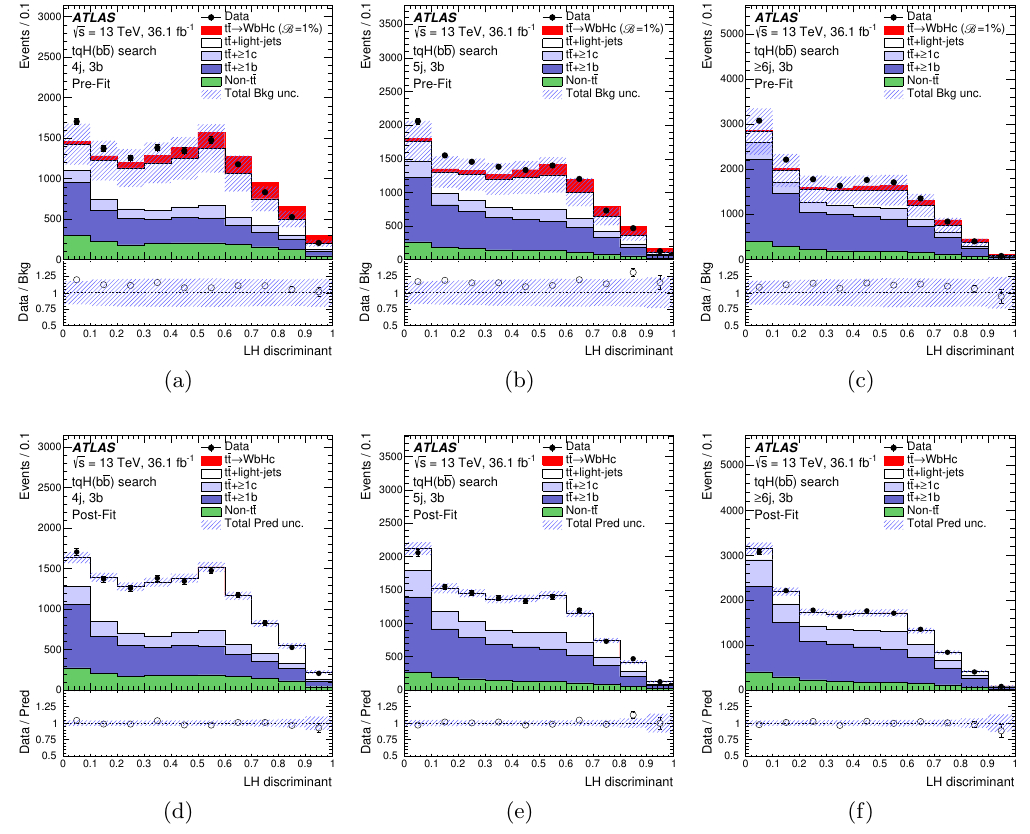
Figure 7 . tqH ( b (cid:22) b ) search: comparison between the data and prediction for the LH discriminant distribution in the regions with three b -tagged jets, before and after the (cid:12)t to data (\Pre-Fit" and \Post-Fit", respectively) under the signal-plus-background hypothesis. Shown are the (4j, 3b) region (a) pre-(cid:12)t and (d) post-(cid:12)t, the (5j, 3b) region (b) pre-(cid:12)t and (e) post-(cid:12)t, and the ( (cid:21) 6j, 3b) region (c) pre-(cid:12)t and (f) post-(cid:12)t. The small contributions from t (cid:22) tV , t (cid:22) tH , single-top-quark, W=Z +jets, diboson, and multijet backgrounds are combined into a single background source referred to as \Non- t (cid:22) t ". In the pre-(cid:12)t (cid:12)gures the expected t (cid:22) t ! WbHc signal (solid red) corresponding to B ( t ! Hc ) = 1% is also shown, added to the background prediction. In the post-(cid:12)t (cid:12)gures, the t (cid:22) t ! WbHc signal is normalised using the best-(cid:12)t branching ratio, B ( t ! Hc ) = ( (cid:0) 0 : 2 +2 : 3 The bottom panels display the ratios of data to either the SM background prediction before the (cid:12)t (\Bkg") or the total signal-plus-background prediction after the (cid:12)t (\Pred"). The hashed area represents the total uncertainty of the background. In the case of the pre-(cid:12)t background uncertainty, the normalisation uncertainty of the t (cid:22) t + (cid:21) 1 b background is not included.